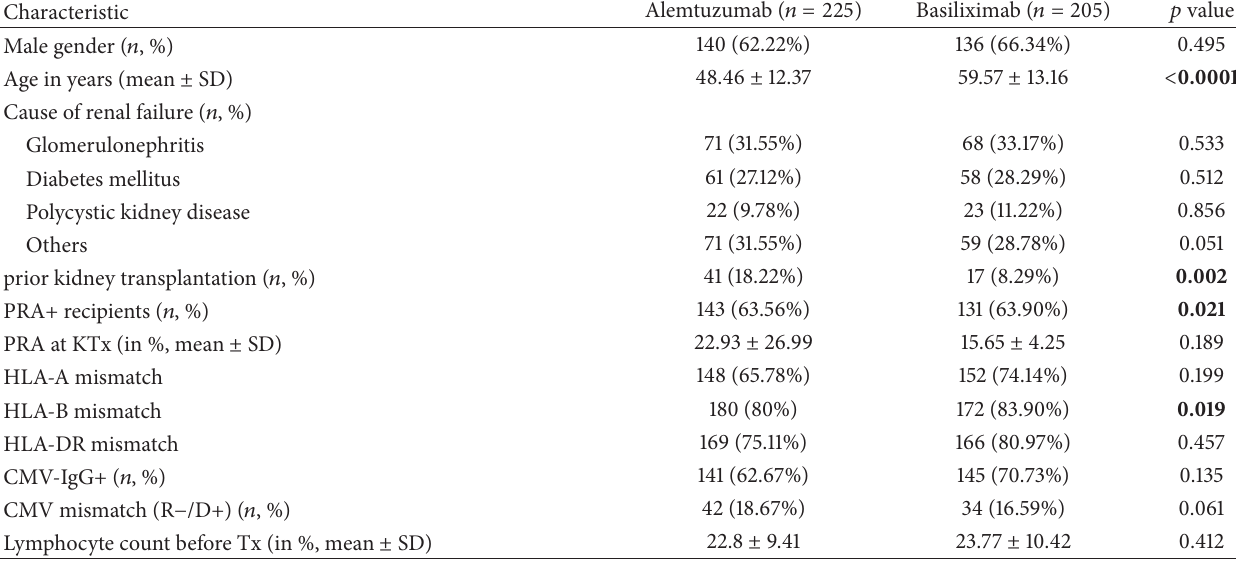
Table 1: Characteristics of 225 (alemtuzumab) and 205 (basiliximab) recipients and solitary kidney transplants.